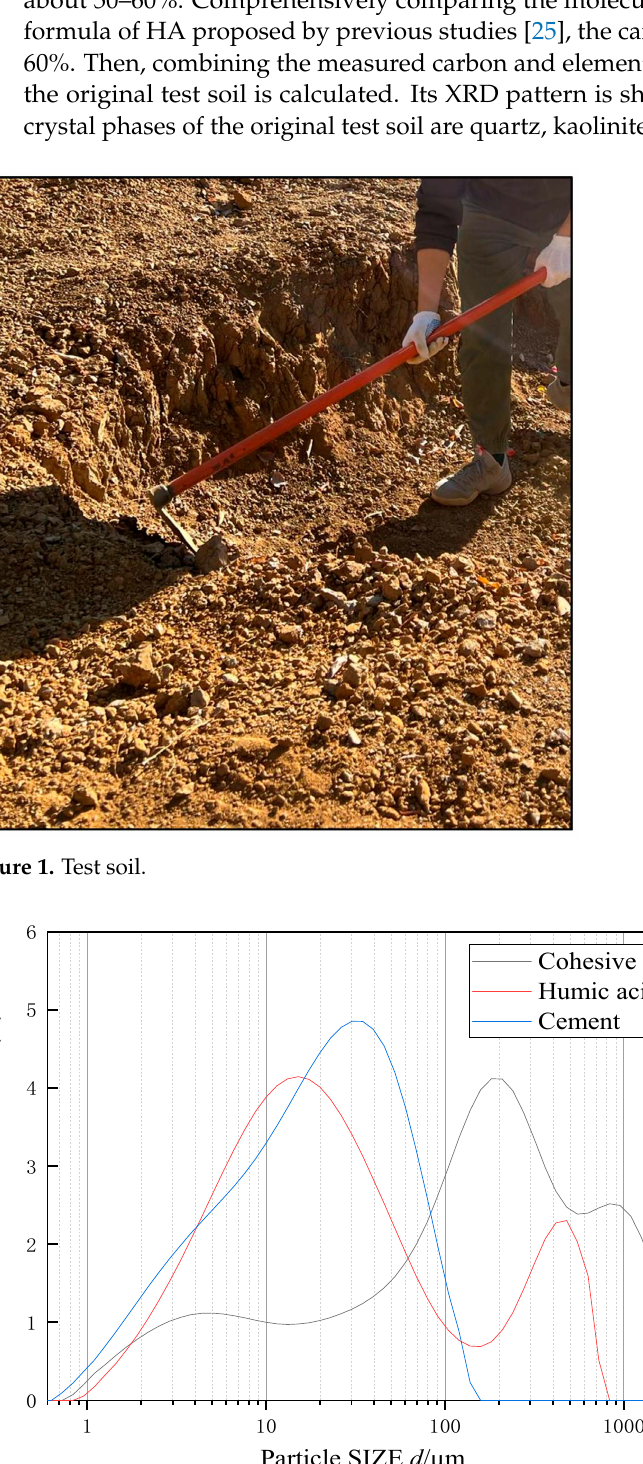
Figure 3. HA reagent.